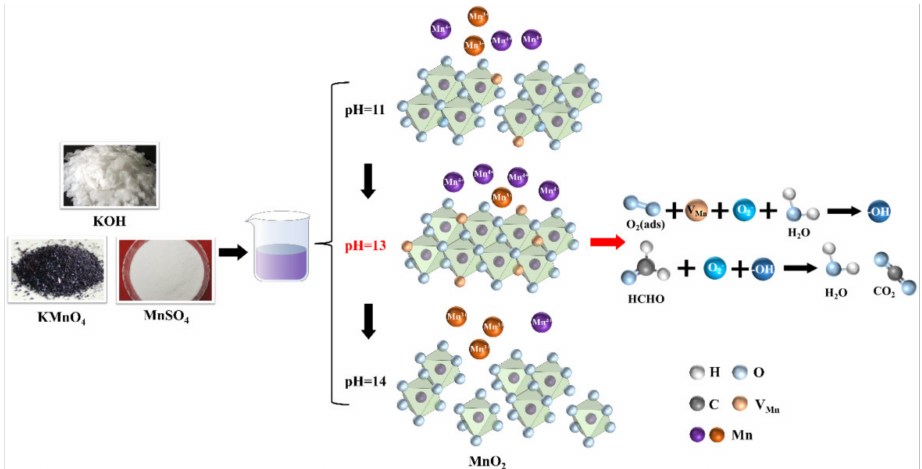
Figure 9. Schematic diagram of the mechanism of HCHO degradation by MnO 2 with different